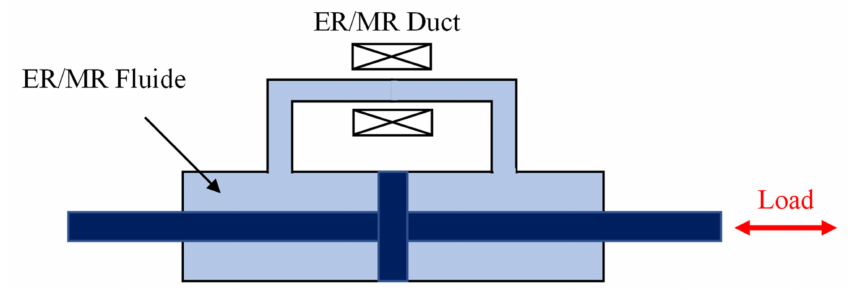
Figure 21. Controllable-fluid